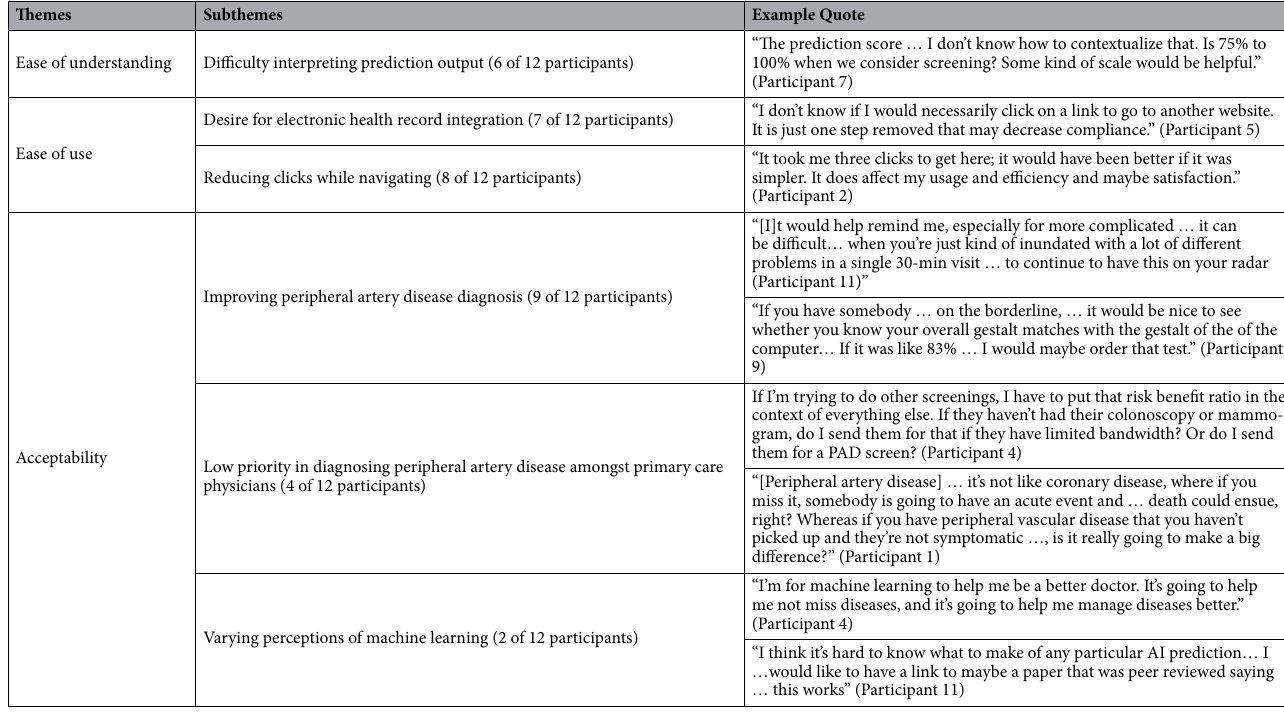
Table 4. Usability themes and